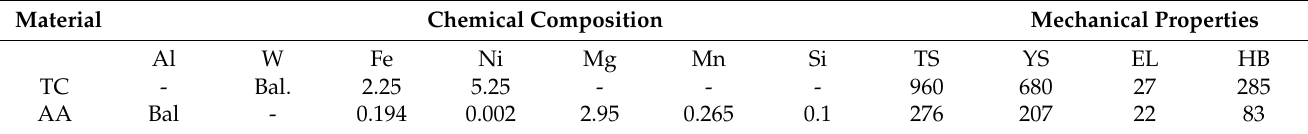
Table 1. Alloying elements (wt.%) and the mechanical properties of the base material. Chemical